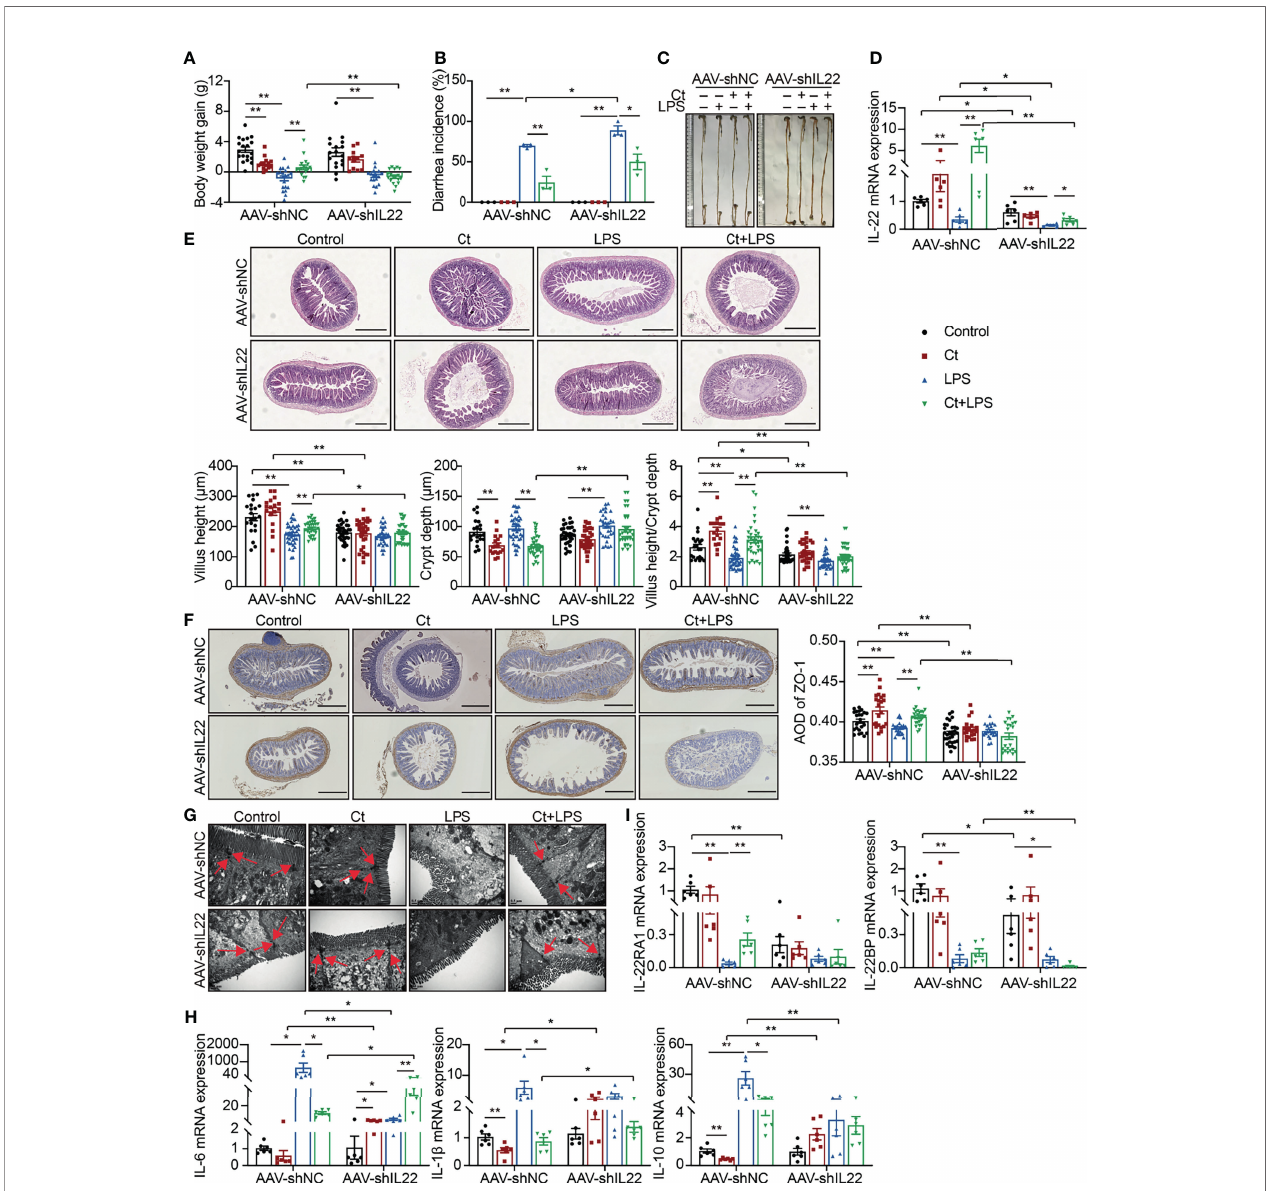
FIGURE 3 | Ct alleviates intestinal barrier dysfunction in an IL-22-dependent manner. C57BL/6 mice were fi rst intraperitoneally injected with AAV-shNC (n=70) and AAV-shIL22 (n=59), after 14 days, mice were randomly divided into 8 groups, namely AAV-shNC-Control (n=19), AAV-shNC-Ct (n=14), AAV-shNC-LPS (n=20), AAV- shNC-Ct + LPS (n=17), AAV-shIL22-Control (n=17), AAV-shIL22-Ct (n=12), AAV-shIL22-LPS (n=18), AAV-shIL22-Ct + LPS (n=12). All samples were collected after 24 h. (A) Body weight gain. (B) Diarrhea incidence. (C) Intestinal length. (D) RT-qPCR analysis of IL-22 in the ileum (n=6). (E) H&E staining. Scale bar: 500 m m. (F) ZO-1 expression. Scale bar: 500 m m. (G) Visualization of microvilli and structure of tight junctions under TEM. Scale bar: 0.5 m m. (H) RT-qPCR analysis of in fl ammatory cytokines including IL-6, IL-1 b , and IL-10 in the ileum (n=6). (I) RT-qPCR analysis of IL-22 and IL-22BP in the ileum (n=6). Data were presented as mean ± SEM. The signi fi cant difference was analyzed by two-way unpaired t-tests. * P < 0.05, ** P <